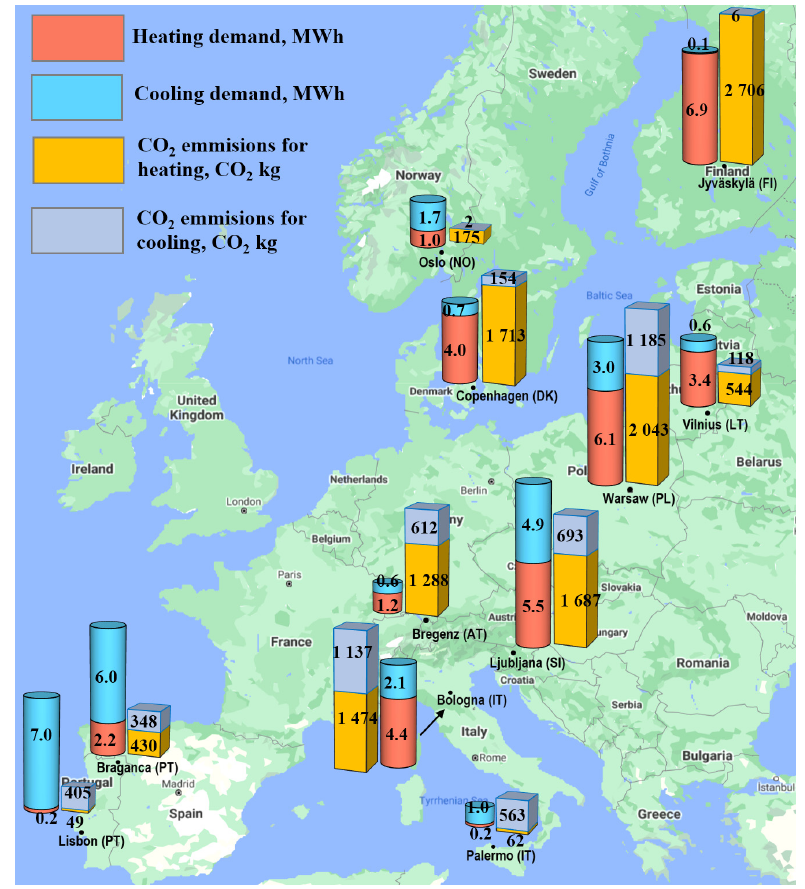
Figure 8. The aggregate primary energy demand for heating and cooling (MWh) in an energy class A+ building and the aggregate carbon dioxide emissions for heating and cooling (kg) in different European climate zones.